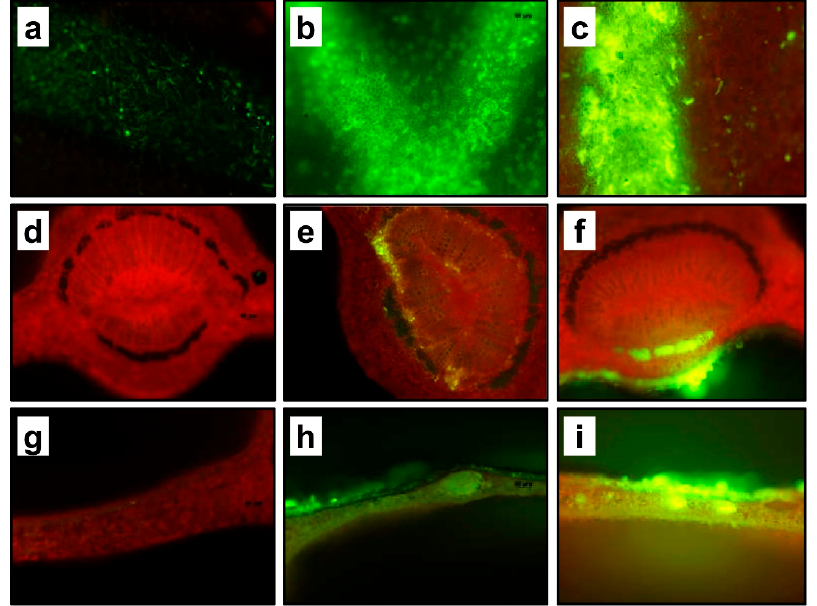
Figure 1. Delivery of dsRNA to citrus phloem through laser micro-perforation. ( a – c ) Fluorescence micrographs of laser-perforated areas on citrus leaves and applied with H 2 O, deoxyglucose, 2-NBDG, and CY-3 labeled dsRNA- PDS, respectively. ( d – f ) cross sections of laser-treated citrus leaf petioles and applied with H 2 O, deoxyglucose, 2-NBDG, and CY-3 labeled dsRNA- PDS, respectively. ( g – i ) cross sections of lased-treated citrus blades and applied with H 2 O, deoxyglucose, 2-NBDG, and CY-3 labeled dsRNA- PDS, respectively. Note the localization of fluorescent deoxyglucose, 2-NBDG, and the CY-3 labeled dsRNA molecules are localized in the phloem ( e , f ). Control leaves were laser-treated, then water was applied instead of dsRNA or fluorescent glucose.